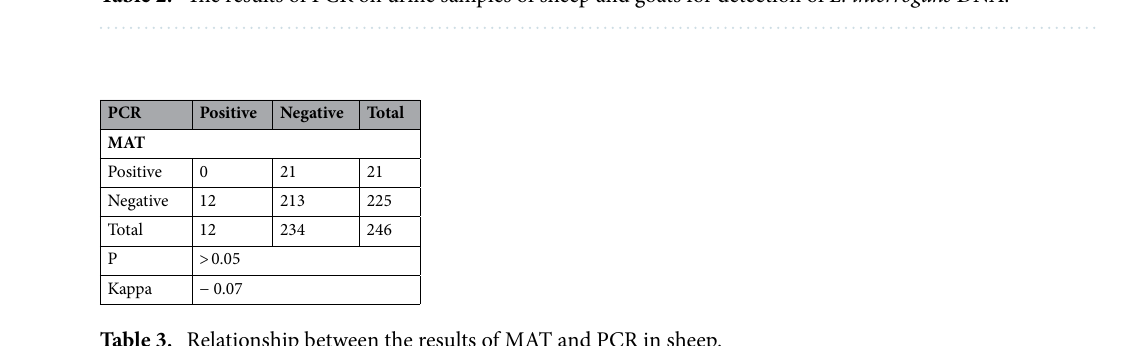
Table 2. The results of PCR on urine samples of sheep and goats for detection of L. interrogans DNA.